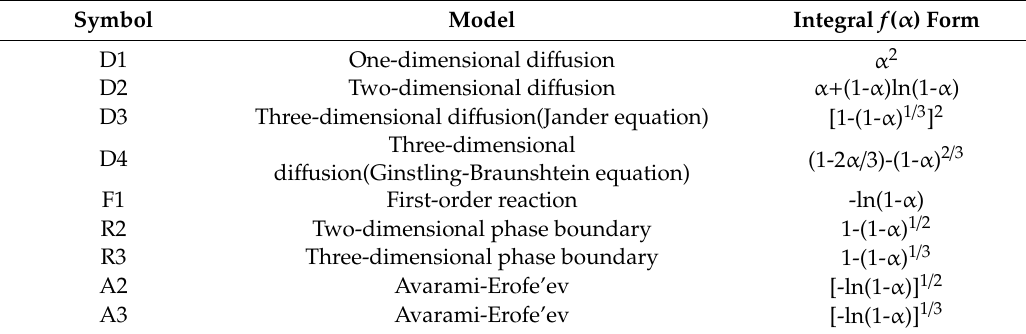
Table 1. Di ff erent kinetic models for isothermal